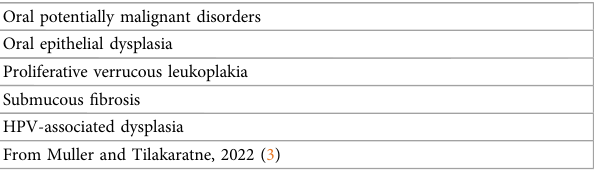
TABLE 1 Oral potentially malignant disorders and oral epithelial